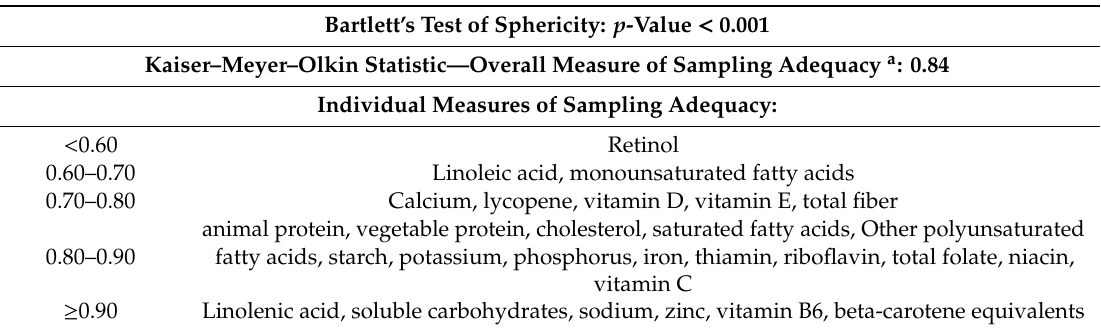
Table 1. Factorability of the correlation matrix of the original nutrients: Bartlett’s test of sphericity and measures of sampling